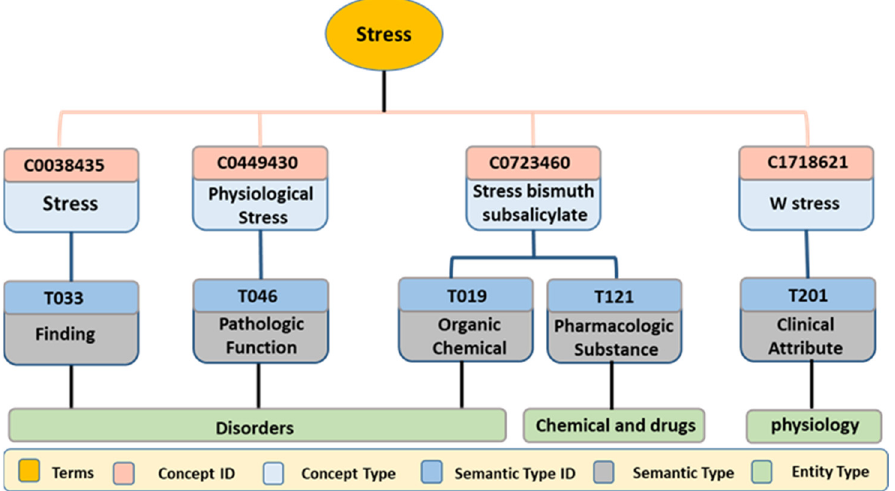
Figure 3. UMLS Metathesaurus concept-extraction case study hierarchical tree.